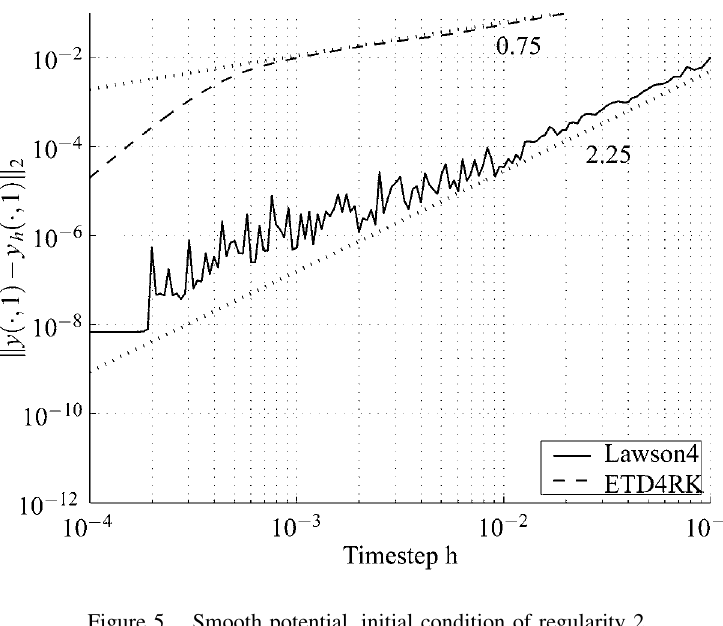
Figure 5. Smooth potential, initial condition of regularity 2.